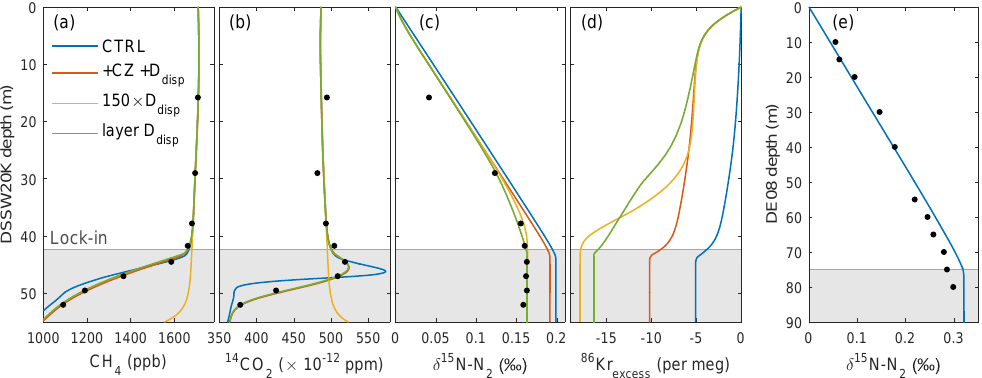
Figure 6. Model simulations and firn air data for the Law Dome DSSW20K (a – d) and DE08 (e) sites, with model scenarios color-coded. The first scenario (CTRL, blue) is a control run with no convective mixing or dispersion to show gravitational equilibrium. The second scenario ( + CZ + D disp , red) includes convective mixing (following Kawamura et al. (2006) with H = 2m and D eddy , 0 = 1 × 10 − 5 m 2 s − 1 ) and dispersion to optimize the fit to all tracers except δ 15 N. The third scenario (150 × D disp , yellow) uses strongly enhanced dispersive mixing to optimize the fit to δ 15 N data. The fourth scenario (layered D disp , green) uses layered dispersion and diffusivity to optimize the fit to all tracer data. Model details and atmospheric trace gas forcings are as in Buizert et al. (2012). Spatial model resolution is (cid:49)z = 0 . 1m for scenarios 1–3, and (cid:49)z = 0 . 01m for scenario 4. (a) DSSW20K methane mixing ratio; (b) DSSW20K 14 CO 2 mixing ratio; (c) DSSW20K